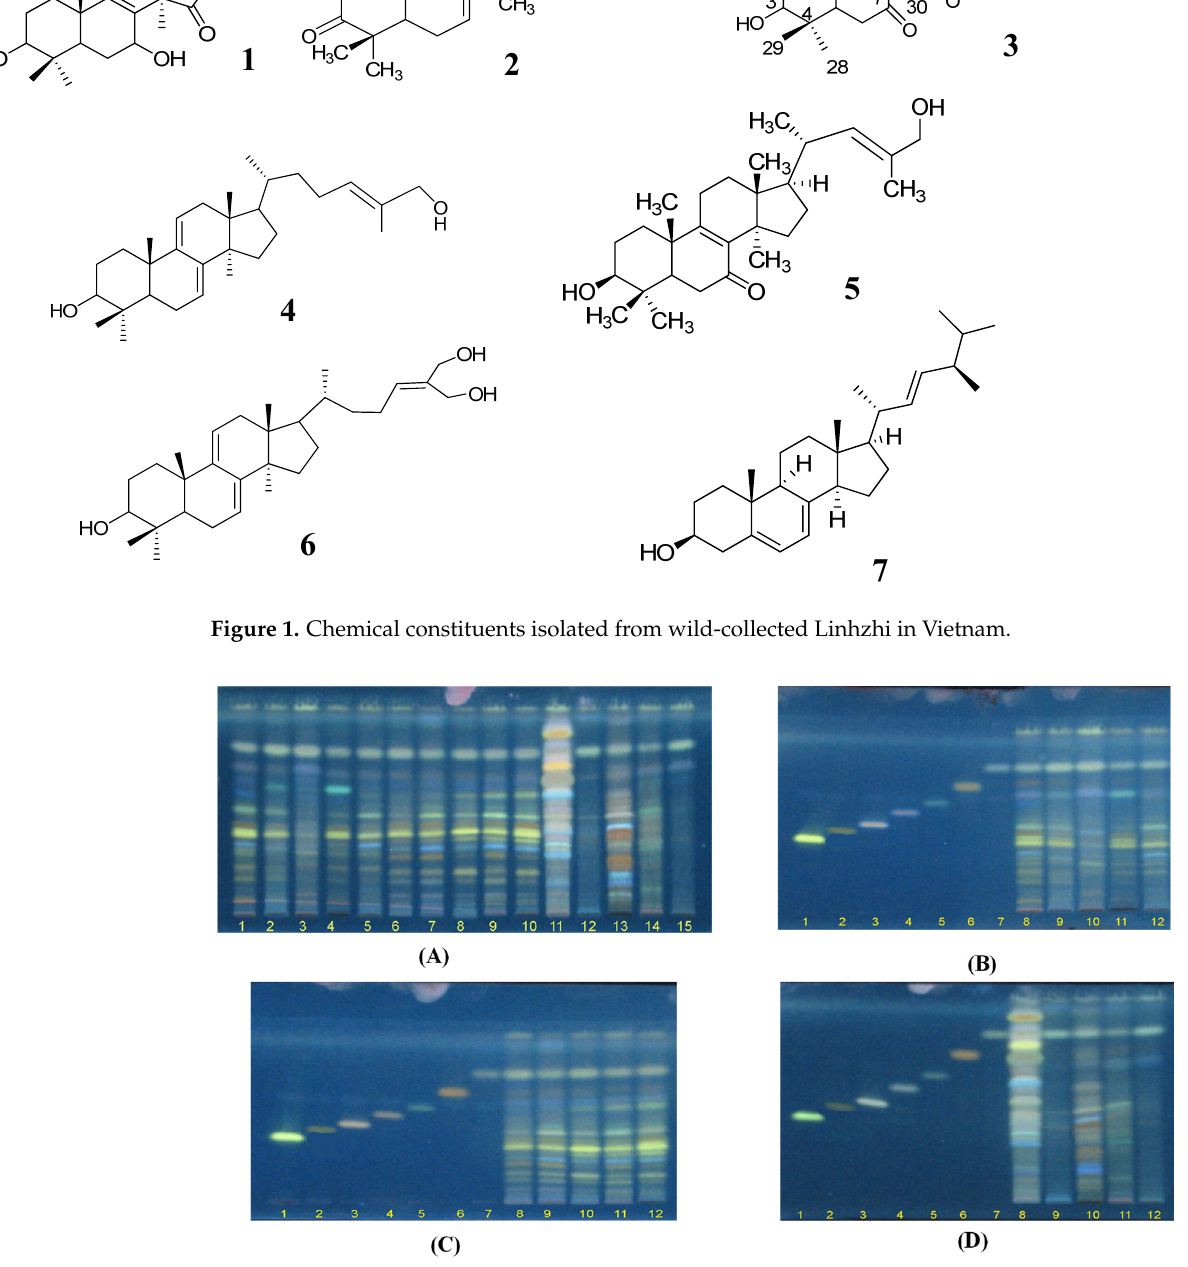
Figure 2. HPTLC fluorescence images under the excitation wavelength of 366 nm. ( A ) 15 samples